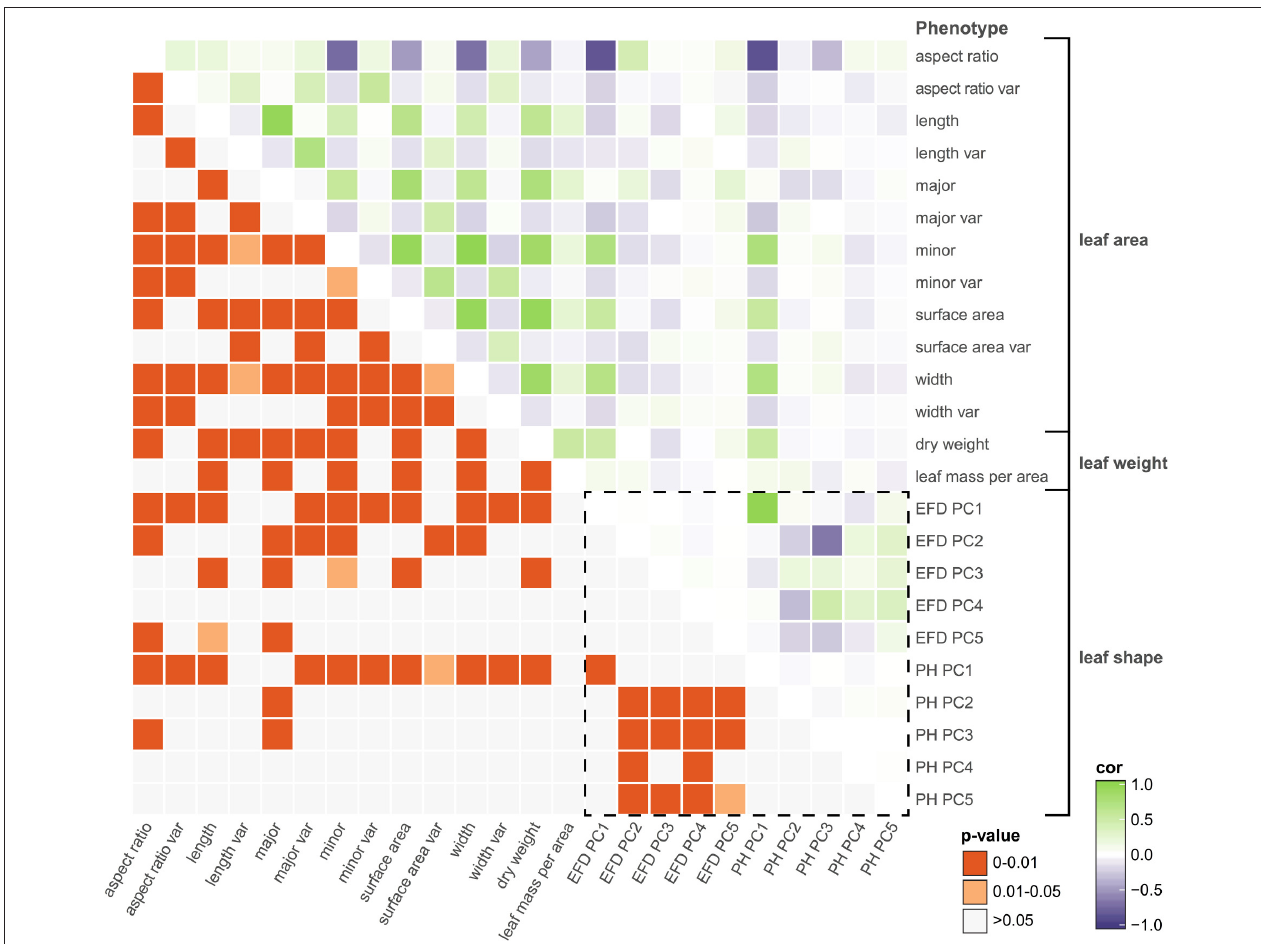
FIGURE 4 | Correlations among leaf phenotypes. Values above the diagonal are colored according to the Pearson’s correlation coefficient, and those below the diagonal indicate Bonferroni-corrected p -values. The box enclosed by the dotted lines indicates comparisons between phenotypes captured by comprehensive morphometric